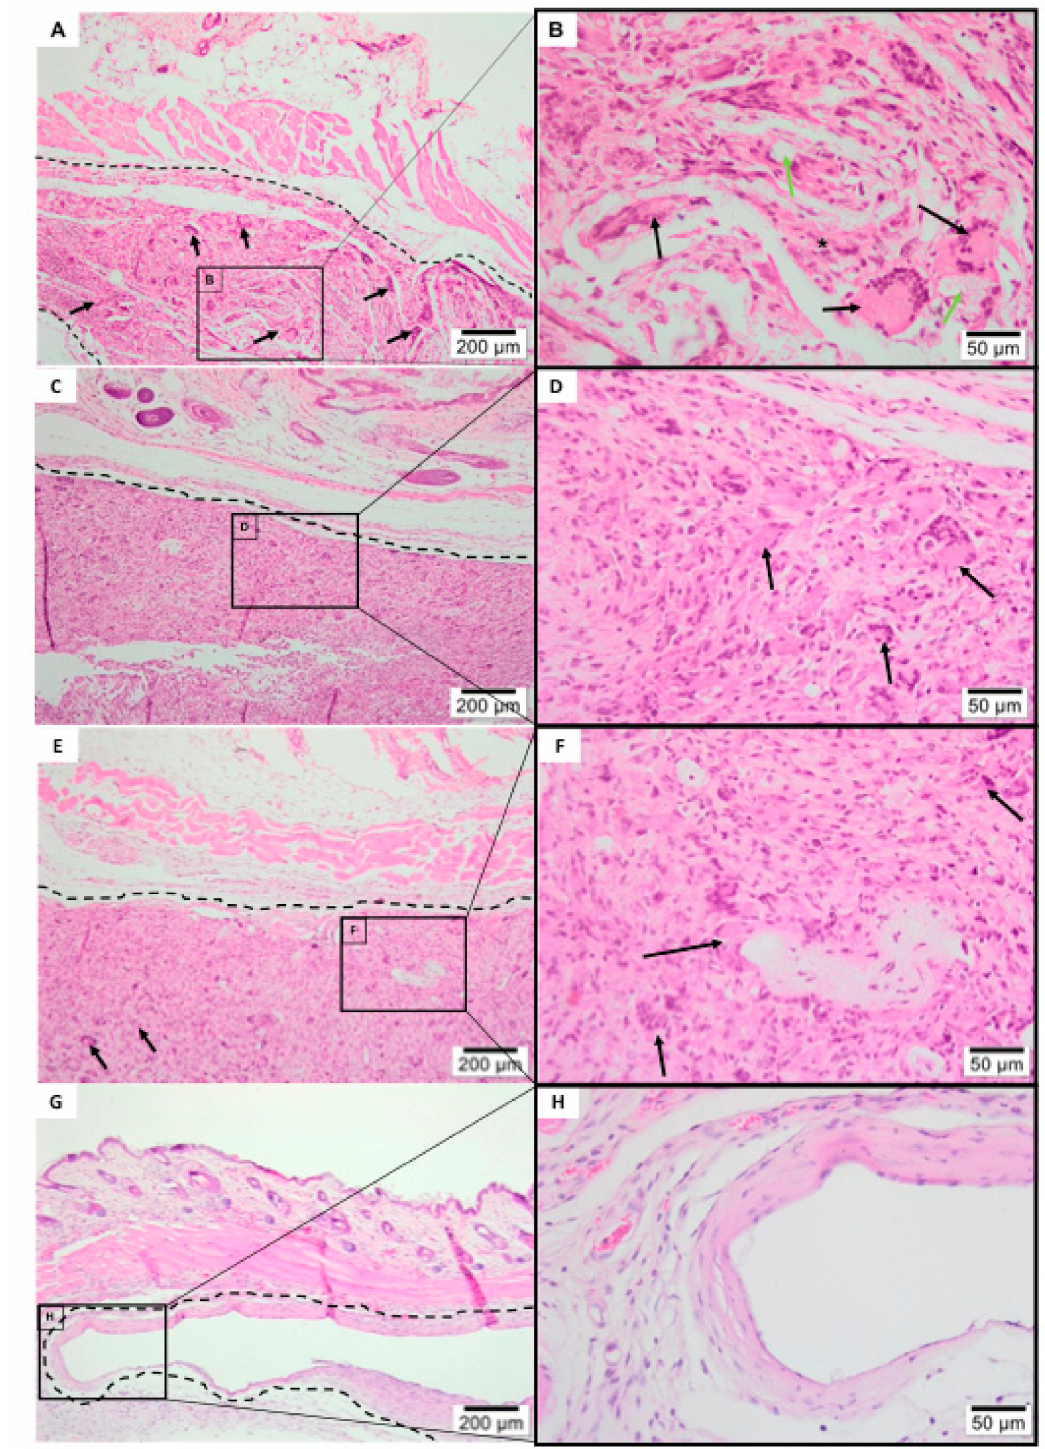
Figure 9. Histology of subcutaneous evaluation of 9-Weeks Post-implantation. Photomicrographs (optical mi- croscopy) stained with hematoxylin/eosin of the membrane implantation area (dotted line) at × 40/ × 400 magnifica- tion. ( A , B ) Tea tree Experimental Group, ( C , D ) Furanone Experimental Group, ( E , F ) Pure PLGA Experimental Group, ( G , H ) Pratix Experimental